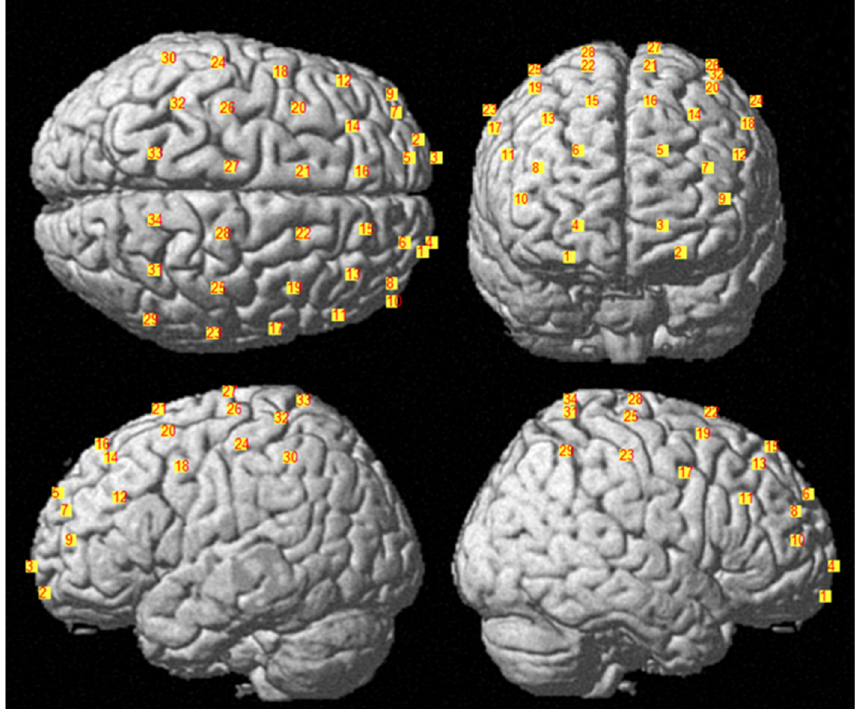
Figure 2. Average channels positions obtained warping the sources and detectors into MNI space. The number associated to each channels is specified in the figure.